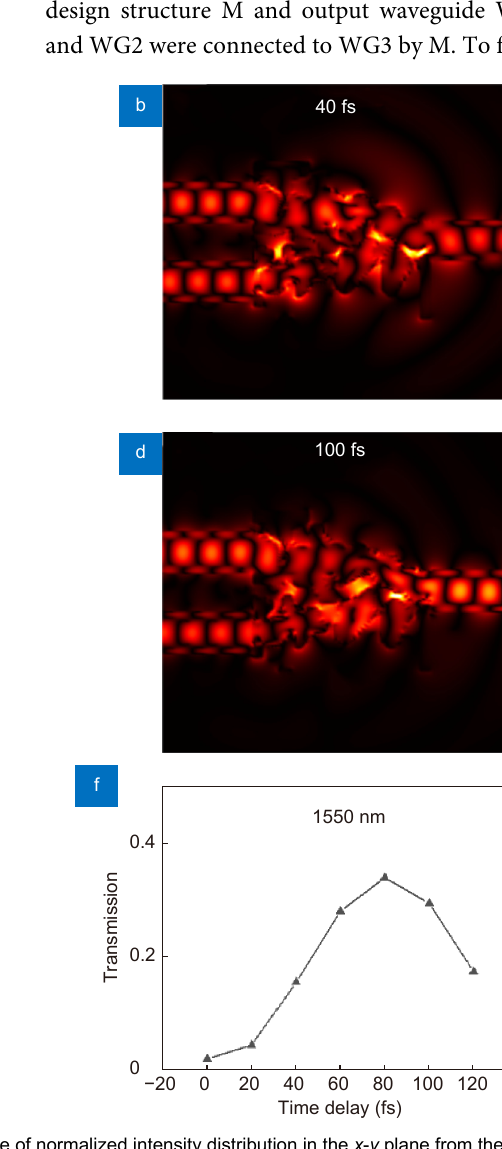
Fig. 3 | Characterization of the all-optical switch. ( a ) The “OFF” state of normalized intensity distribution in the x - y plane from theoretical calcu- lation at t =0 fs. ( b–d ) The “ON” state of normalized intensity distribution in the x - y plane from theoretical calculation at t =40 fs, 80 fs and 100 fs, respectively. ( e ) Transmission of the output of the all-optical switch under different delay time at 1500 nm-1600 nm. ( f ) Transmission of the out- put of the all-optical switch under different delay time at 1500